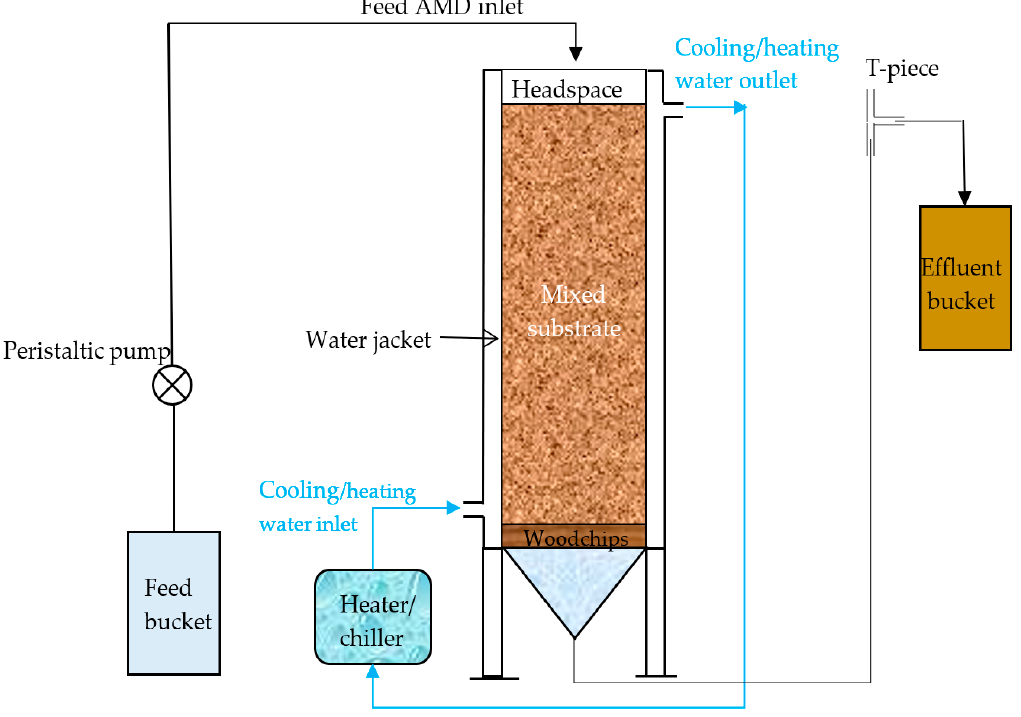
Figure 1. Schematic diagram of the reactors.